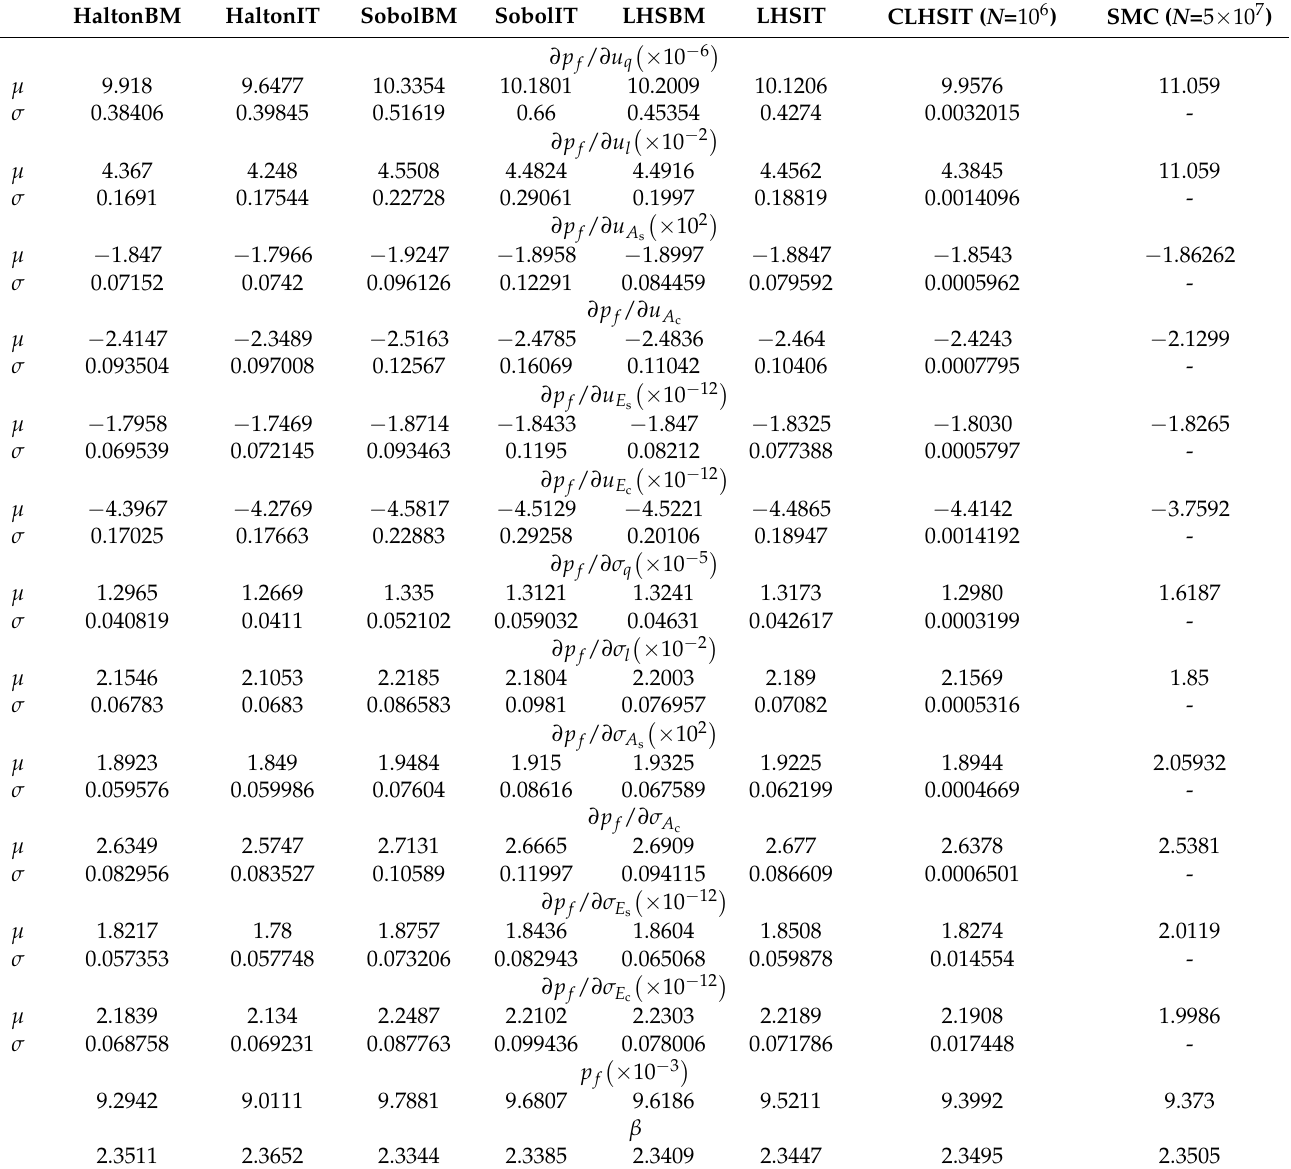
Table 6. Reliability and sensitivity results of different methods in Example 3 when N = 50.